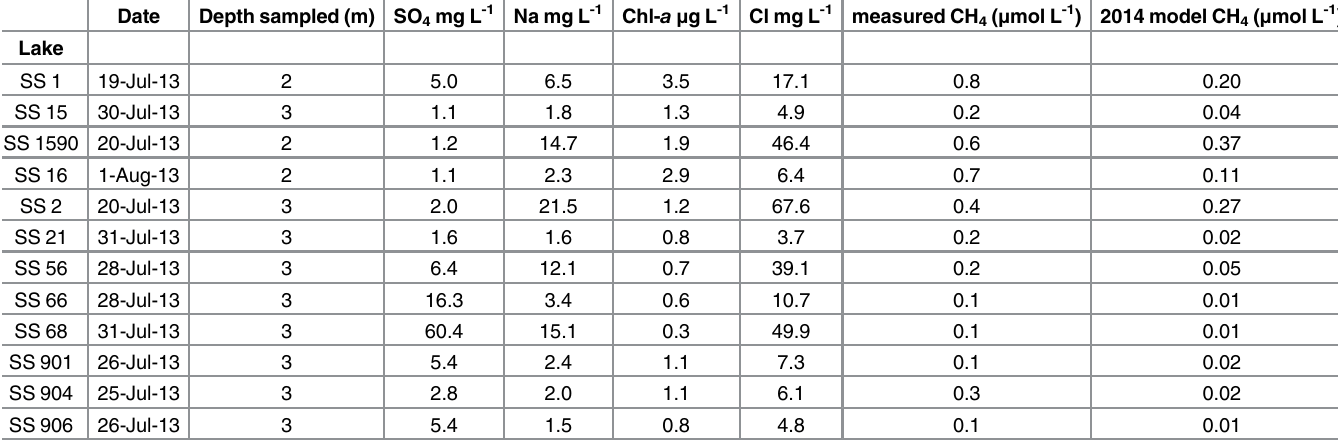
Table 4. Lake characteristics for pilot lakes sampled in 2013.